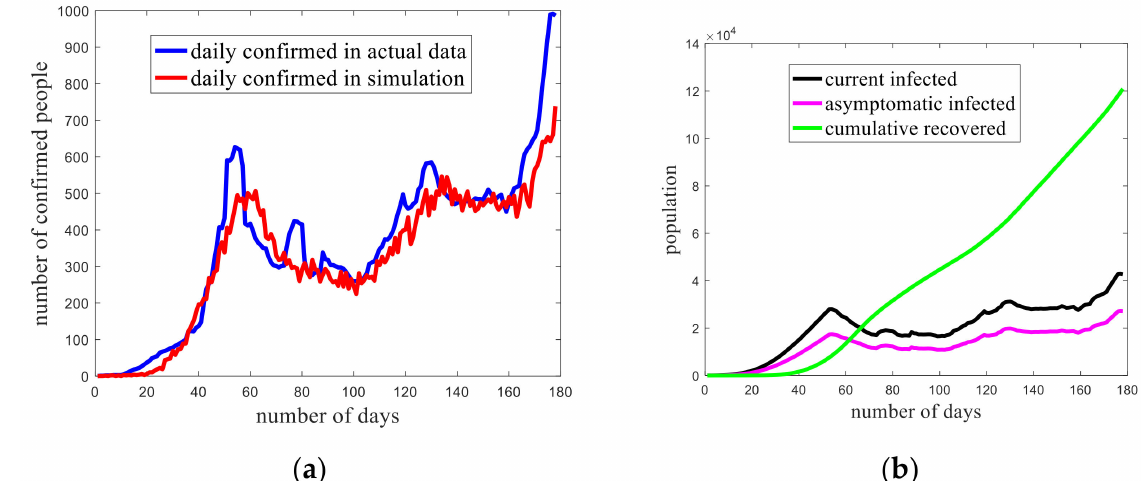
Figure 4. ( a ) The comparison result of Iowa in terms of daily confirmed. ( b ) The trend of the number of infected and recovered in